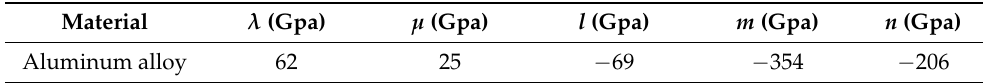
Figure 1. Directional relationship between L CR wave propagation and stress in orthogonal coordinates. Table 1. Second-order and third-order constants of aluminum